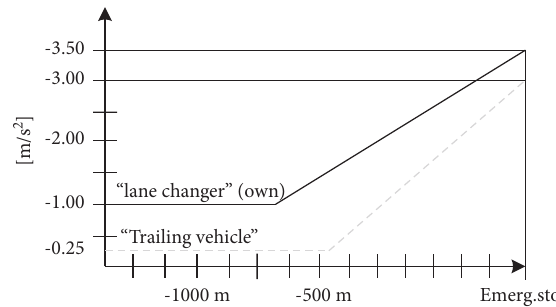
Figure 4: Mandatory lane change parameter relationship.